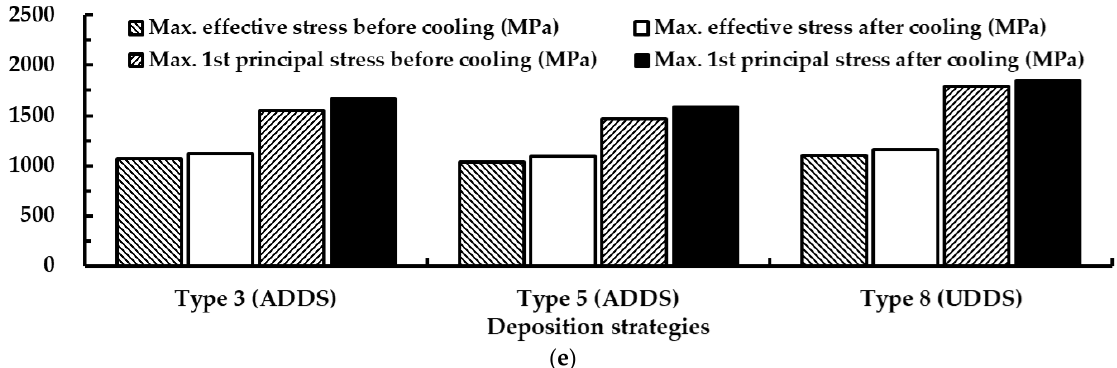
Figure 12. Influence of deposition strategies on residual stress distributions after the completion of cooling for a large volume deposition: ( a ) three-dimensional effective stress distribution for different FDSs; ( b ) regions to estimate cross- sectional and planar residual stress distributions; ( c ) cross-sectional and planar effective stress distributions for different FDSs; ( d ) cross-sectional and planar first principal stress ( σ p1 ) distributions for different FDSs; ( e ) maximum residual stresses for different FDSs.